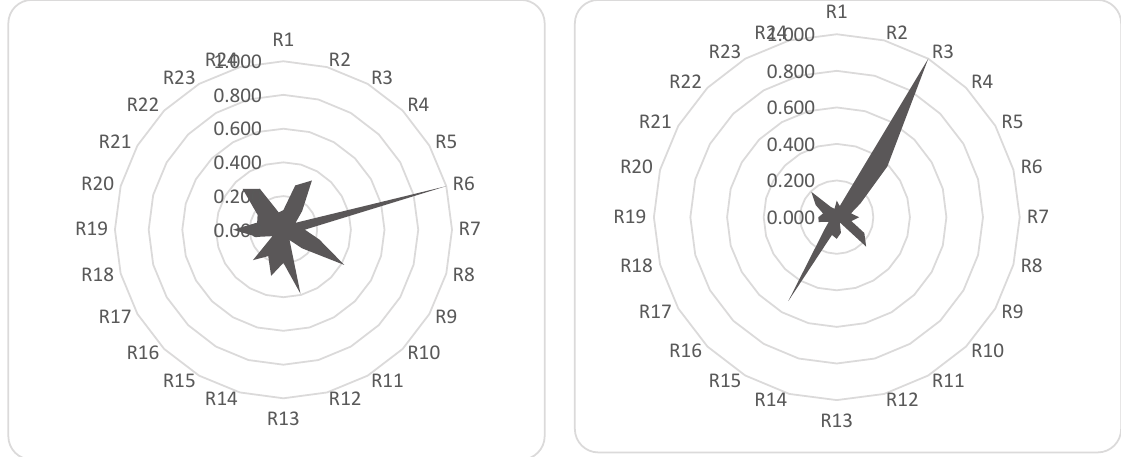
Fig.1.2. Efficiency scores Cargo transportation the regions of